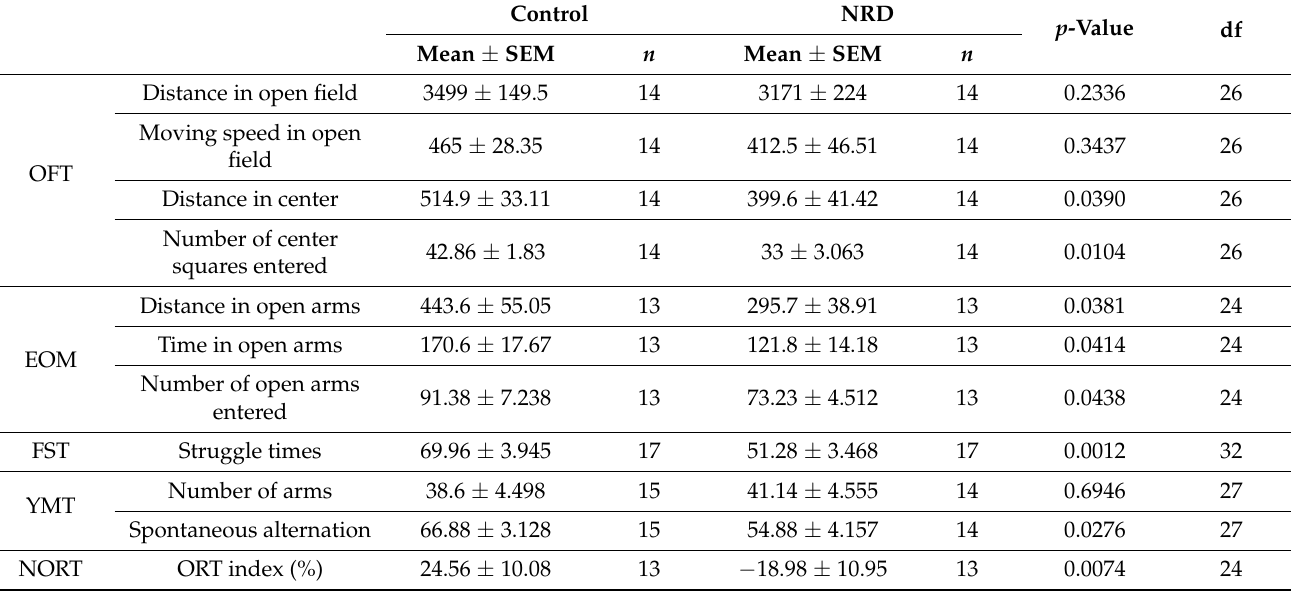
Table 1. Summary of data from the behavioral experiments.